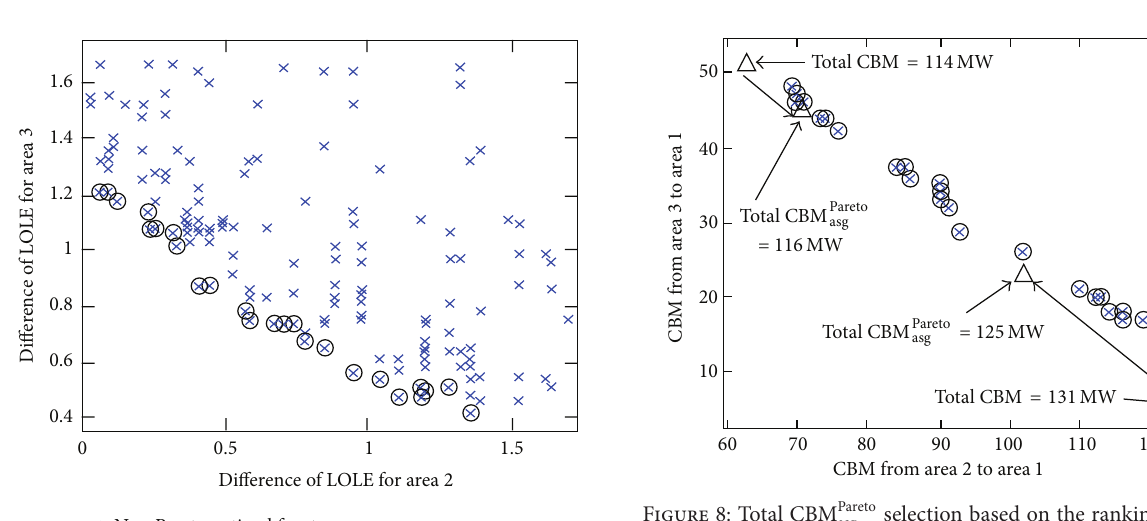
of assisting areas due to the lowest total LOLE and total LOLE difference associated with the 1st ranking index.